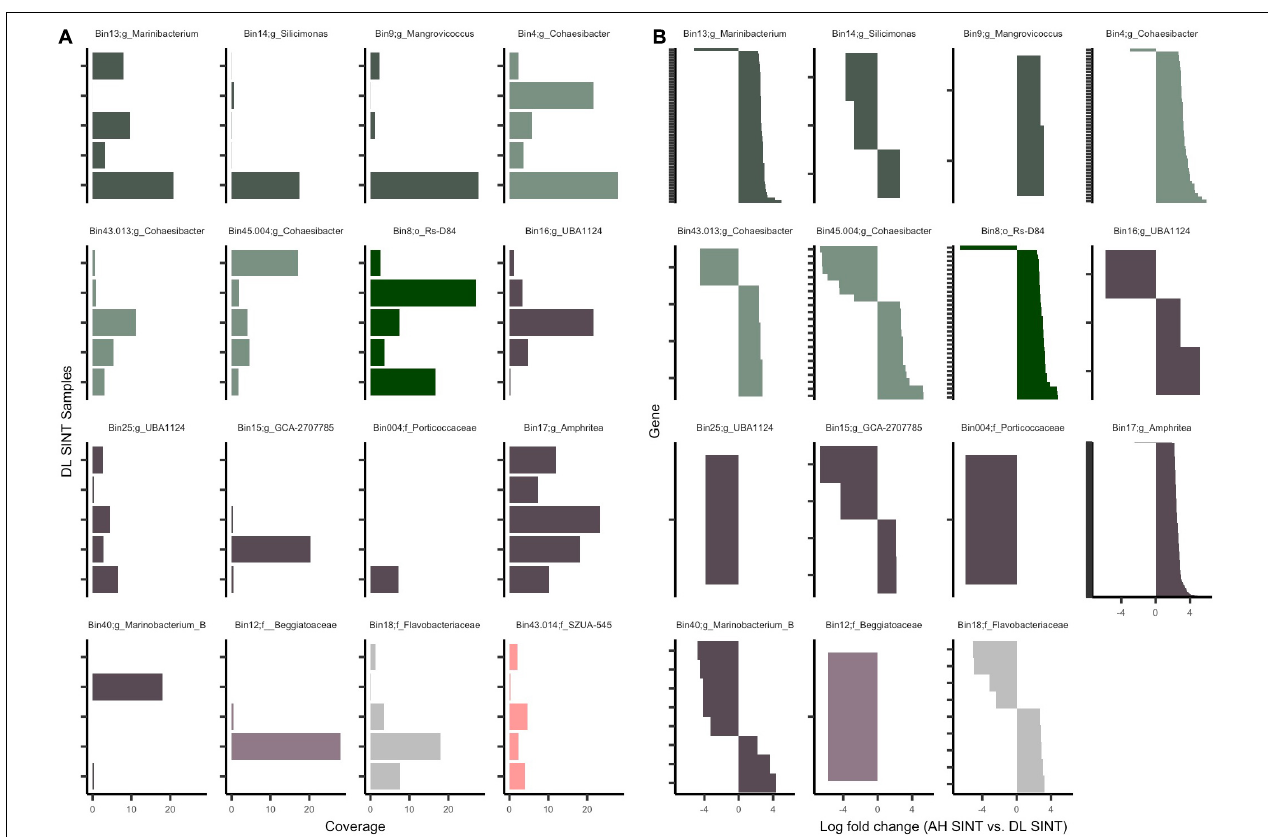
FIGURE 6 | Mapped reads to the open reading frames (ORFs) of metagenome-assembled genomes (MAGs). (A) Coverage of ORFs in the five-disease lesion (DL) samples from Stephanocoenia intersepta (SINT). (B) Significantly differentially abundant genes (padj ≤ 0.05 from edgeR analysis) among apparently healthy (AH) SINT and DL SINT coral samples. Gene sets ( y -axis) are parsed by MAGs and show the log-fold change between AH SINT and DL SINT. Each bin color represents bacterial classes: Gammaproteobacteria (purple), Alphaproteobacteria (green), and Flavobacteria (gray). Within each class, the different color tones represent different clades and bacterial